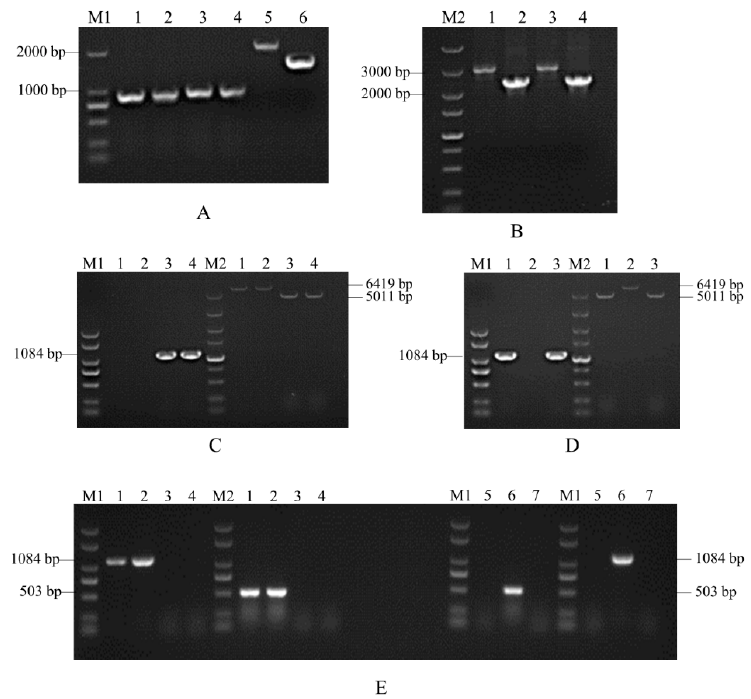
Figure 2. Construction and validation of the SsCI80130 gene knockout mutants and complementary mutants. Lane M1 is the 2000 marker and lane M2 is the 5000 marker ( A ) PCR amplification. Lanes 1, 2, 3, and 4 represent the left and right flanking fragment under the wild-type ( Ss16 + and Ss16 − ) background, respectively; lanes 5 and 6 represent the upstream and downstream fragment of the Hpt gene, respectively. ( B ) Fusion-PCR. Lanes 1 and 3 represent the fusion fragments of the left flanking fragment and the upstream Hpt fragment under the wild-type background, respectively, while lanes 2 and 4 represent the fusion fragments of the right flanking fragment and downstream Hpt fragment, respectively. ( C ) Validation of the knockout mutant Δ Ss80130 + under the Ss16 + background. In ( C ), lanes 1–3 are transformants and lane 4 represents the wild-type Ss16 + . Lane 1 and 2 are both the knockout mutant Δ Ss80130 + . ( D ) Validation of the knockout mutant Δ Ss80130 − under the Ss16 − background. In ( D ), lane 2 and lane 3 are transformants and lane 1 represents the wild-type Ss16 − . Lane 2 was the knockout mutant Δ Ss80130 − . ( E ) Validation of the complementary mutants ( COM80130 + and COM80130 − ). In the left half, lane 4 is the knockout mutant Δ Ss80130 + and lane 1–3 represent transformants under the Δ Ss80130 + background. In the right half, lane 7 is the knockout mutant Δ Ss80130 − and lane 5–6 represent transformants under the Δ Ss80130 − background. ( E ) denotes that lane 1 and lane 2 are both COM80130 + , and lane 6 is COM80130 − . 3.3. Effects of the SsCI80130 Gene on Morphology and Growth of S. scitamineum It was observed that the sporidial colony morphology of the SsCI80130 gene knockout mutants ( Δ Ss80130 + and Δ Ss80130 − ) on YePSA plates was not different from that of the wild-type ( Ss16 + and Ss16 − ) and complementary mutants ( COM80130 + and COM80130 − ) (Figure 3A). In contrast, the growth rate of the knockout mutants was found to be significantly slower than that of the wild type, while the growth rate of the complementary mutants basically returned to that of the wild type (Figure 3B,C). Under a microscope, the haploid sporidia of the knockout mutants, complementary mutant, and the wild type were all in the shape of one long oval rod (Figure 3D), which indicated that the deletion of the SsCI80130 gene did not affect the S. scitamineum sporidial morphology.